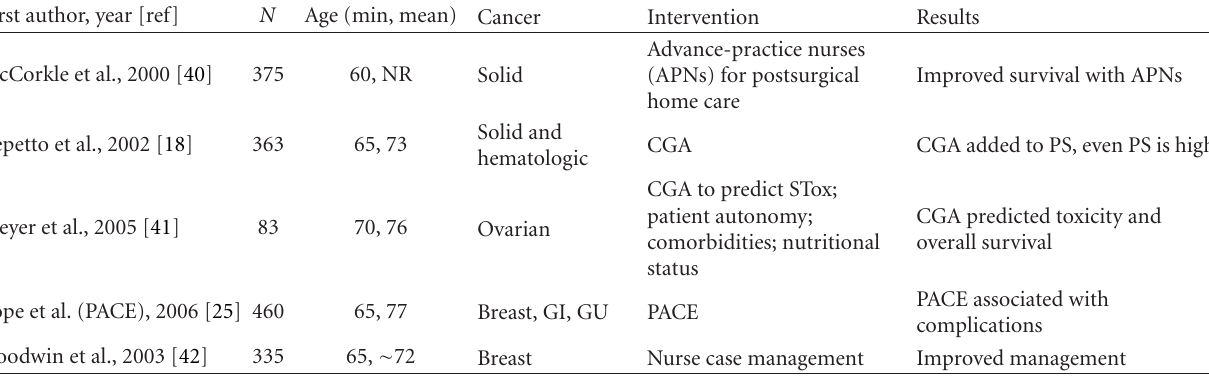
Table 2: Prospective studies on the e ff ect of geriatric assessment before cancer